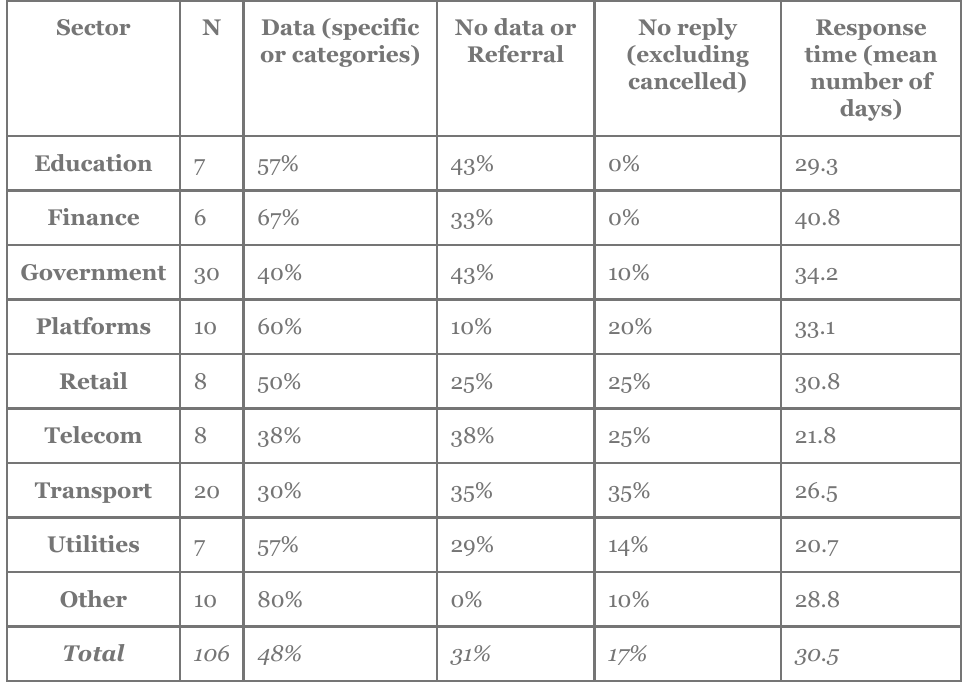
Table 2: Access request response classification and time (by